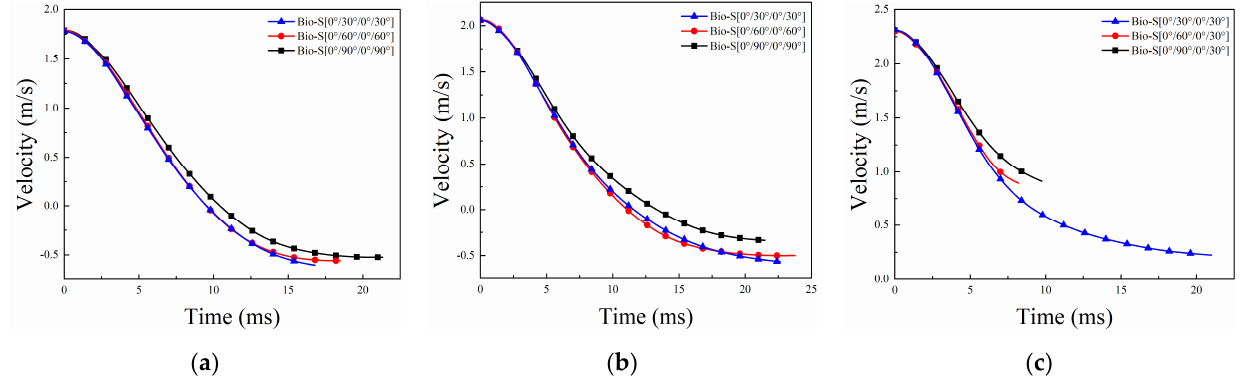
Figure 15. Velocity-time curves of the Bio-S composite plates with different angles of middle layer configurations under different impact energy levels: ( a ) 15 J; ( b ) 20 J; ( c ) 25 J.